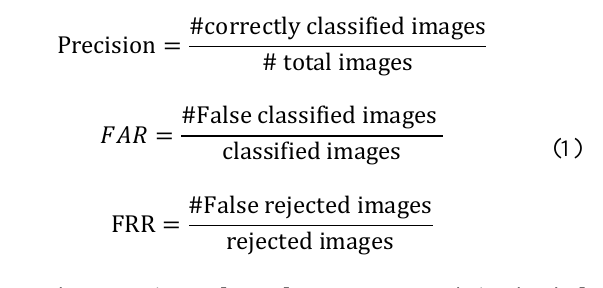
Table 1. Burning Image Classification